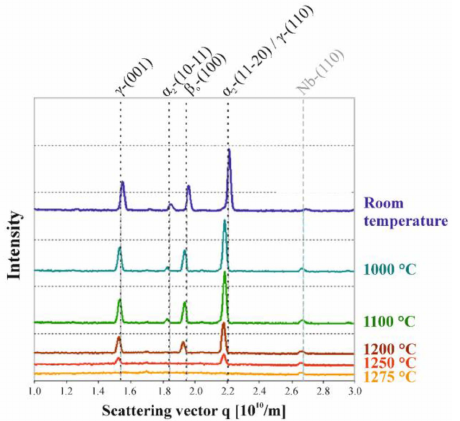
Figure 6. Neutron diffraction patterns of a TNM alloy obtained during isothermal segments at selected temperatures [85]. Between 1100 and 1200 ˝ C, the α 2 reflections vanish, while the β o phase disorders between 1200 and 1250 ˝ C. The γ phase, which shows no disordering, dissolves in the temperature range between 1250 and 1275 ˝ C.